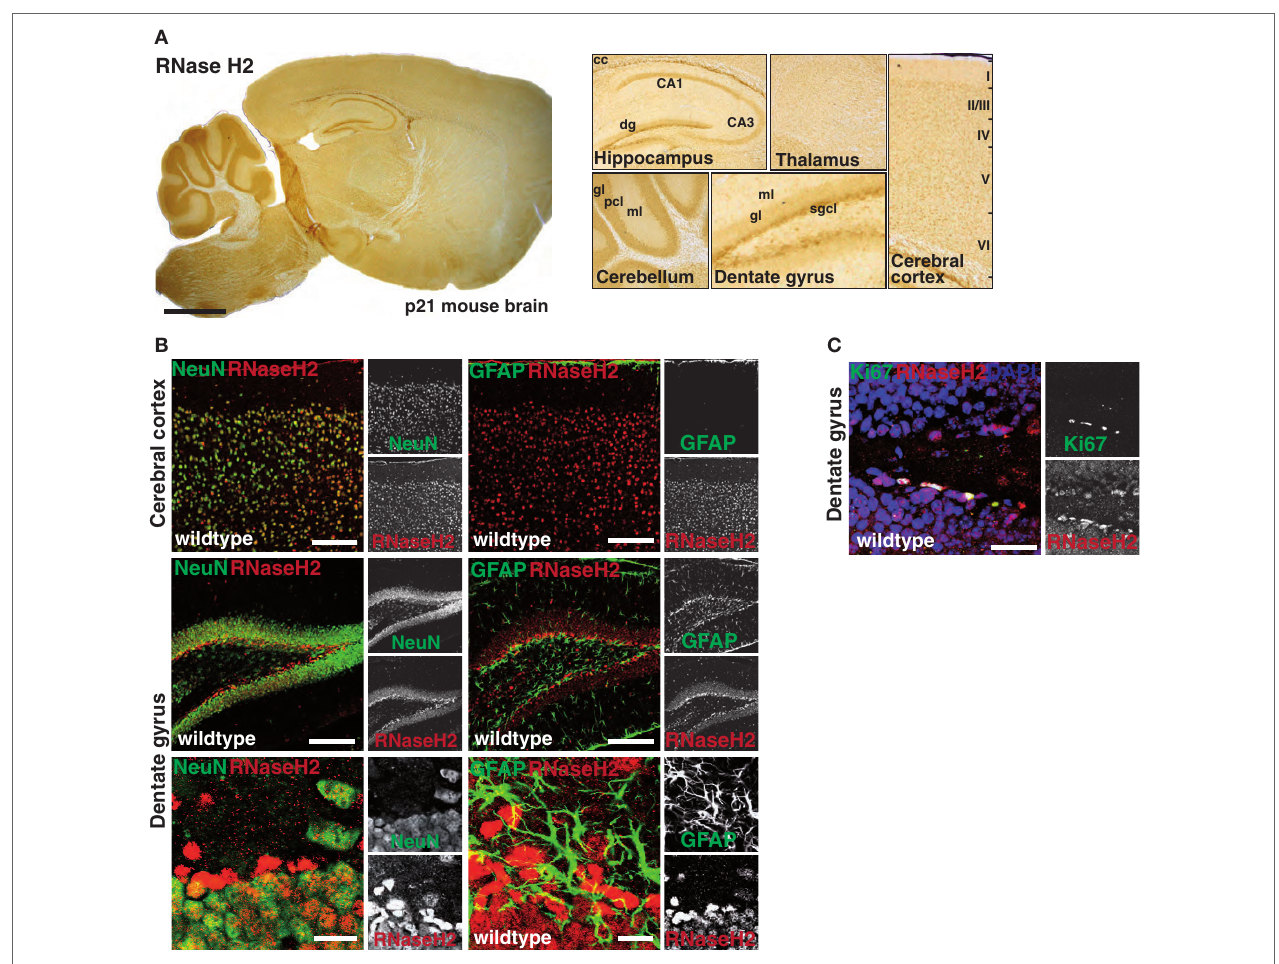
FigUre 1 | Expression of RNase H2 in the murine central nervous system. (a) Sagittal sections from p21 mouse brains were stained with an RNase H2-specific antiserum followed by a biotinylated secondary antibody, streptavidin-coupled HRP, and developed with the chromogenic substrate 3,3 ′ -Diaminobenzidine (DAB). Note the high expression of RNase H2 in the corpus callosum (cc) and hippocampus, with particularly high expression in the subgranular cell layer (sgcl) of the dentate gyrus (dg). Cornu Ammoni (CA), molecular layer (ml), granular layer (gl). (B) Co-immunofluorescence staining for RNase H2 (red) with the neuronal marker NeuN (green, left panel) and astroglia marker GFAP (green, right panel) shows striking co-localization of RNaseH2 in neuronal cells expressing NeuN in both the cerebral cortex and dg. Scale bar = 150 µm (upper four panels), 10 µm (lower two panels) (c) Co-immunofluorescence staining for RNase H2 shows highest expression of RNase H2 in Ki67-positive proliferating cells. Scale bar = 30 µm.